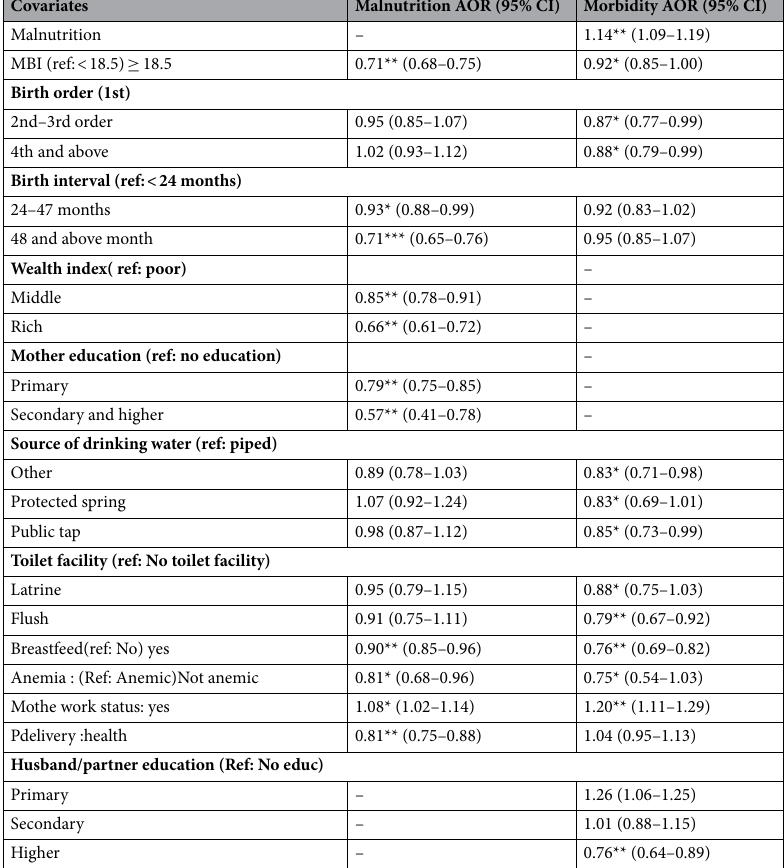
Table 3. Direct effects of risk factors on child malnutrition and morbidity from GSEM. AOR Adjusted Odds Ratio, CI confidence interval. **P < 0.001; *P <